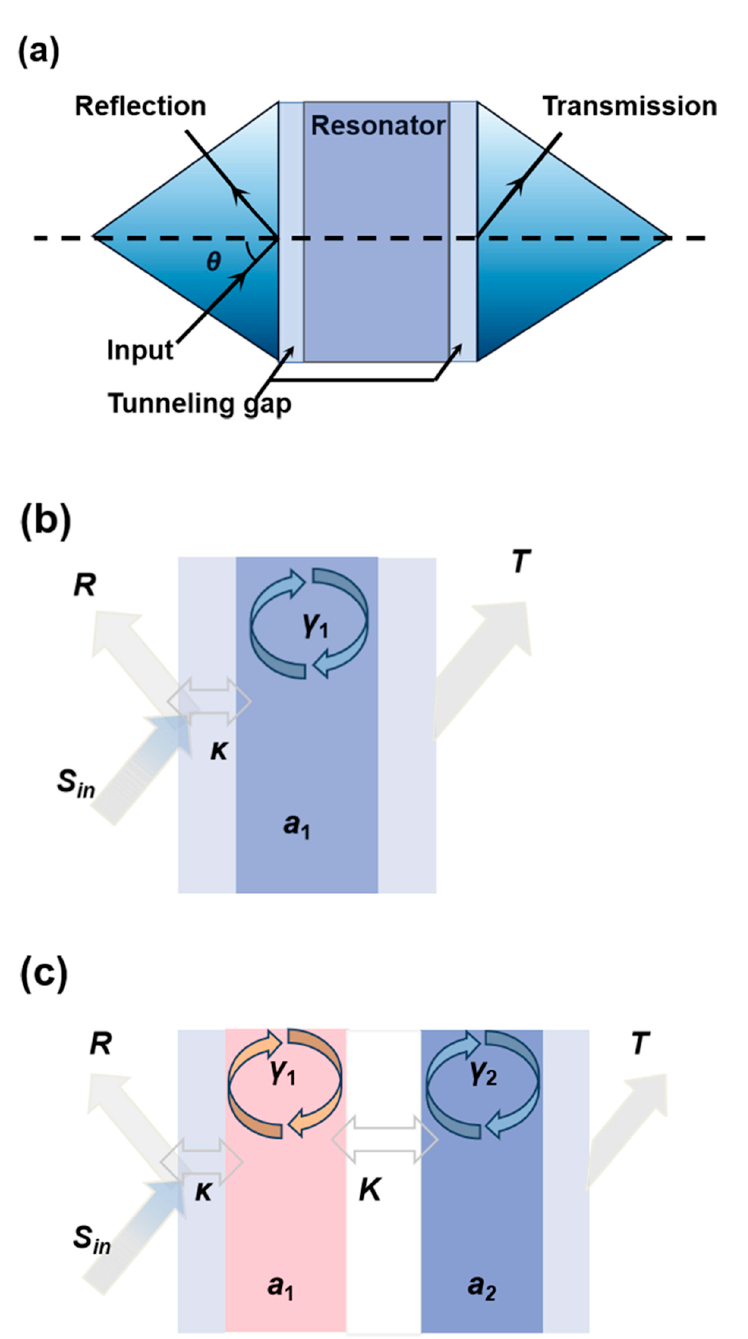
Figure 2. Schematic diagram of the ROTE resonator ( a ), the ROTE resonator model ( b ), and the coupled ROTE resonators model ( c ).